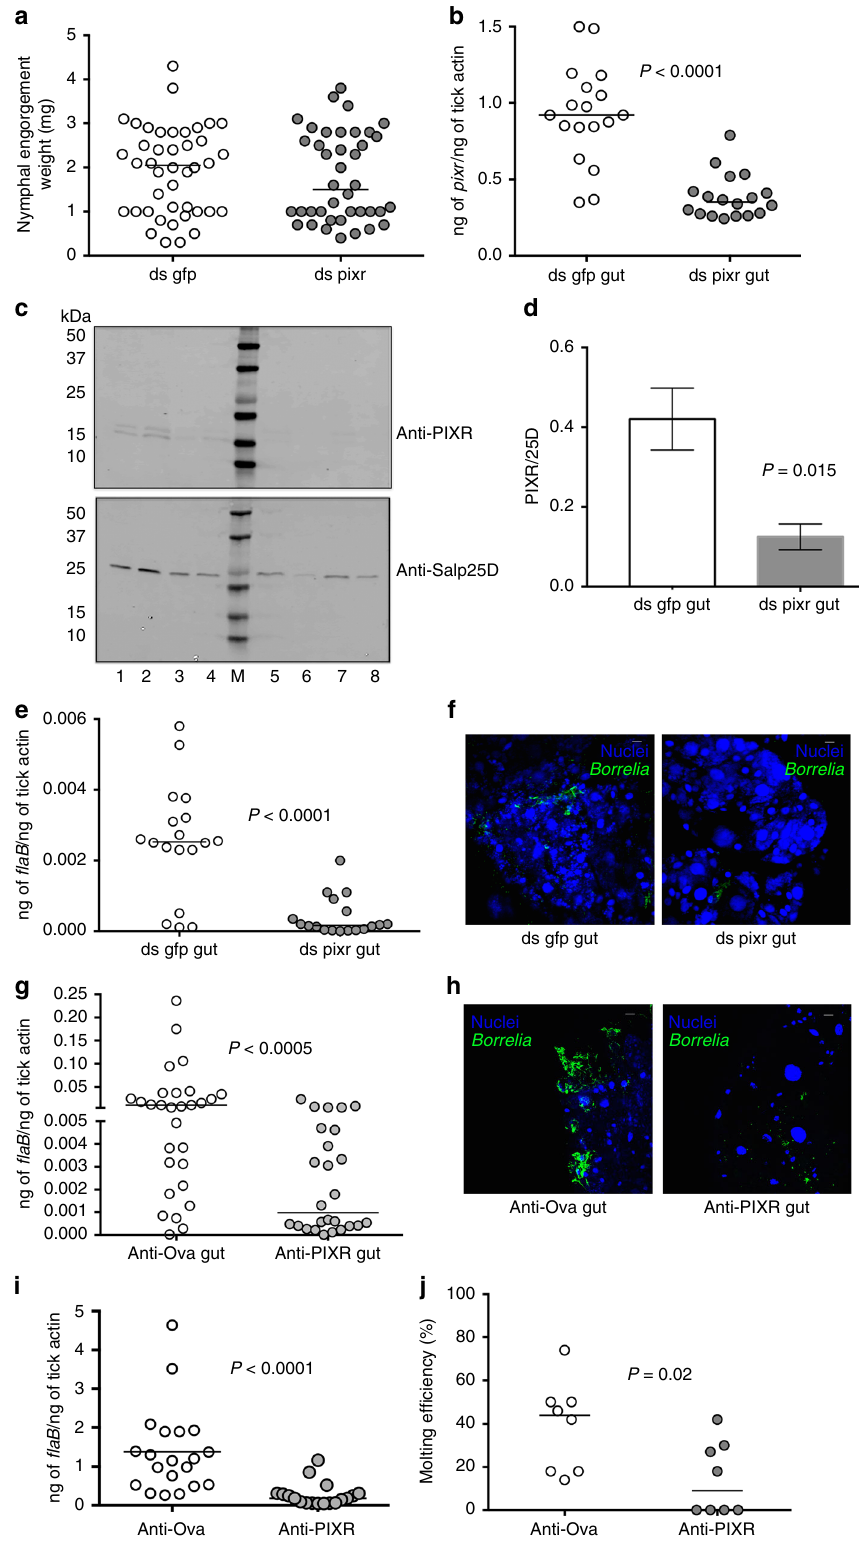
nymphal guts showed decreased expression of the PIXR/PIXR2 doublet in ds pixr RNA-injected ticks compared to control/ds gfp RNA-injected ticks (Fig. 3c and Supplementary Fig. 8C). Con- trary to our expectation pixr -silenced nymphs showed